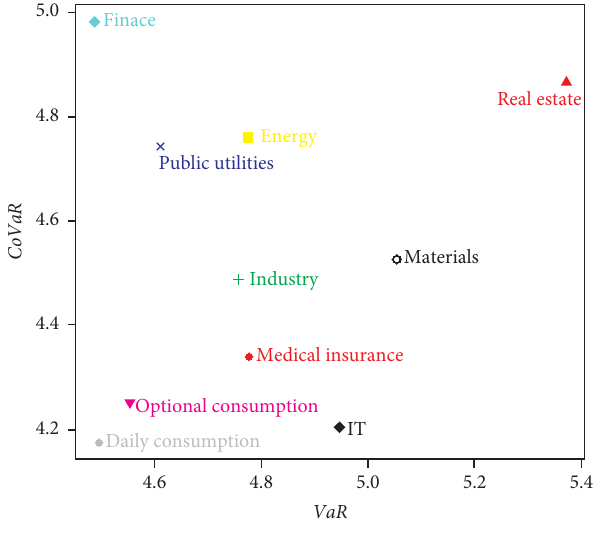
Figure 7: VaR vs. CoVaR by industry.